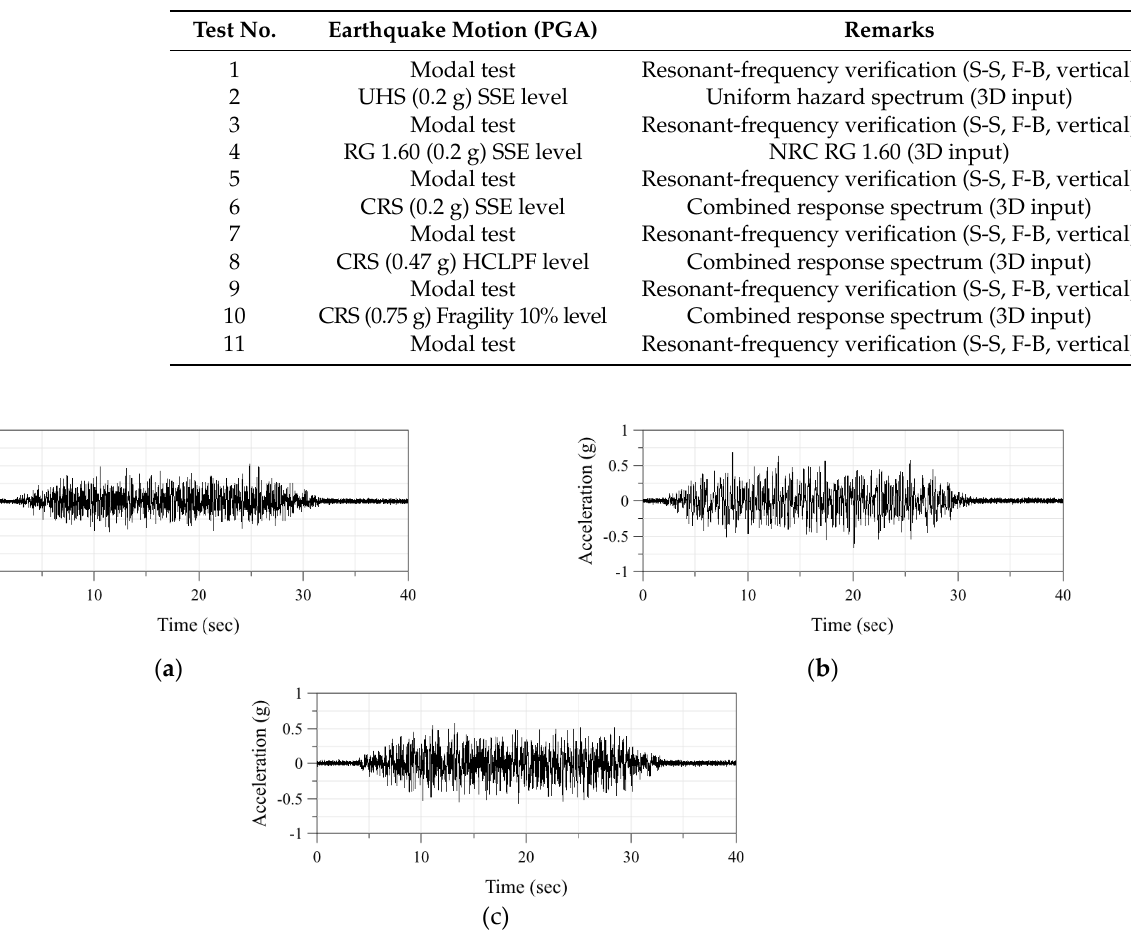
Figure 5. Acceleration time history for front to back depending on input motions: ( a ) uniform hazard spectrum (UHS), ( b ) Regulatory Guide 1.60 design spectrum (RG 1.60), and ( c ) combined response spectrum